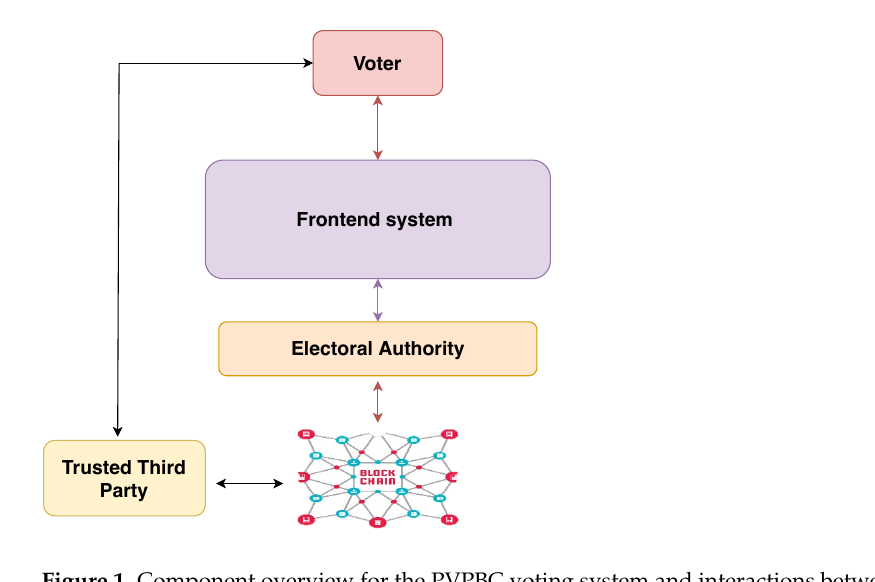
Figure 1. Component overview for the PVPBC voting system and interactions between the election actors: the election authority, the trusted third party, the voter and the front-end system. PVPBC is supported by